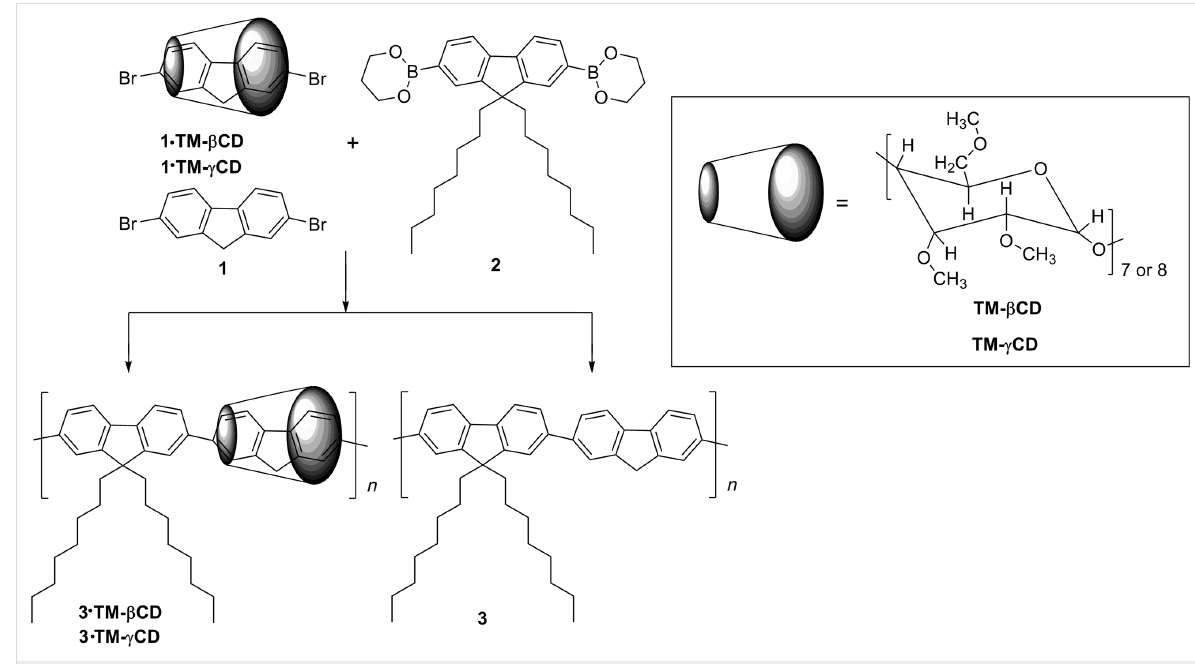
mer 2 , and all the characteristic protons have been identified, Figure 1. Figures S4–S7 in Supporting Information File 1 show ence 3